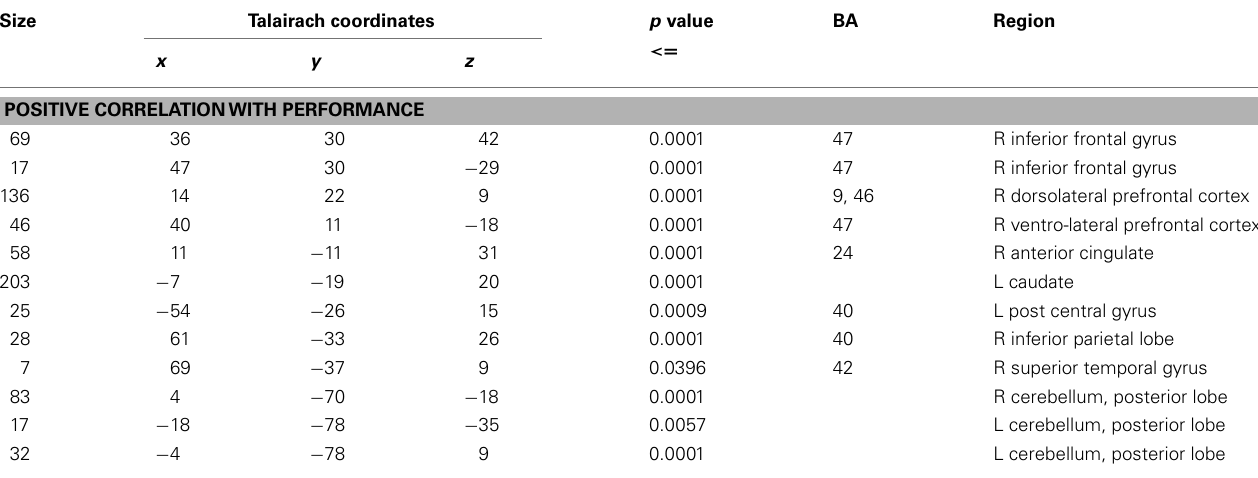
Table 2 | Results of a whole-brain regression analysis showing brain areas where activation has positive correlation with performance during time discrimination contrast with IQ as a